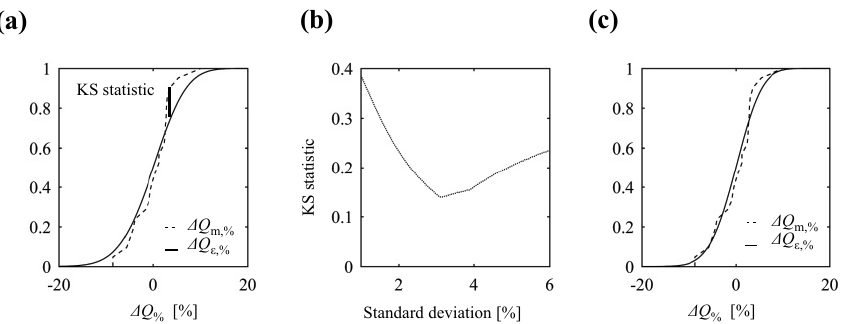
Figure 1. (a) ECDF and corresponding KS statistic of both (cid:49)Q m , % and (cid:49)Q (cid:15), % with µ = 0% and σ = 4%. (b) KS statistics with µ = 0% and different values for σ . (c) ECDF of both (cid:49)Q m , % and (cid:49)Q (cid:15), % with µ = 0% and σ = 3 . 12%. All plots are made for low flow data and a Gaussian error